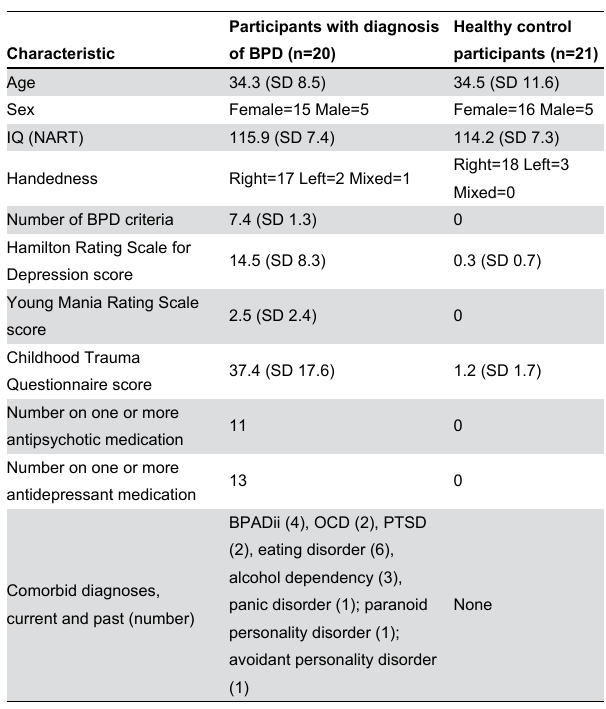
Table showing population demographics and mean questionnaire scores for control and BPD